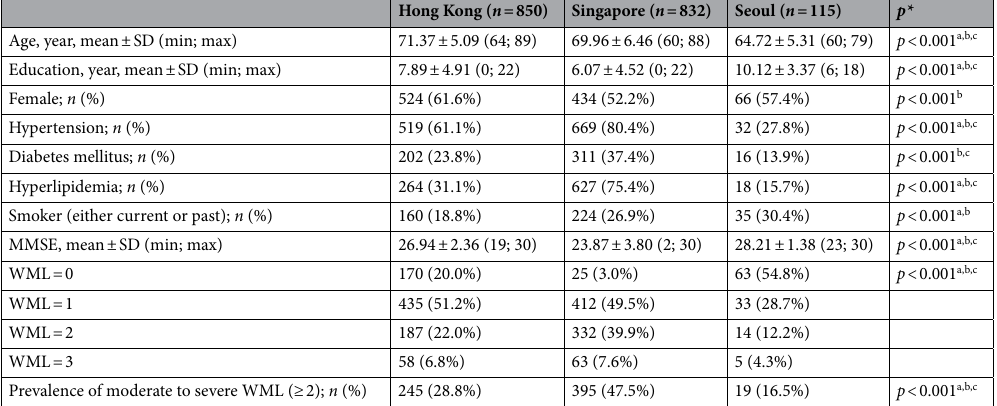
Table 4. Clinical demographics of the control group. This table showed the clinical demographics of the control group. MMSE Mini-mental state examination, WML White matter lesion. a Hong Kong versus Seoul. b Hong Kong versus Singapore. c Seoul versus Singapore. *Bonferroni correction is applied to the alpha (α =